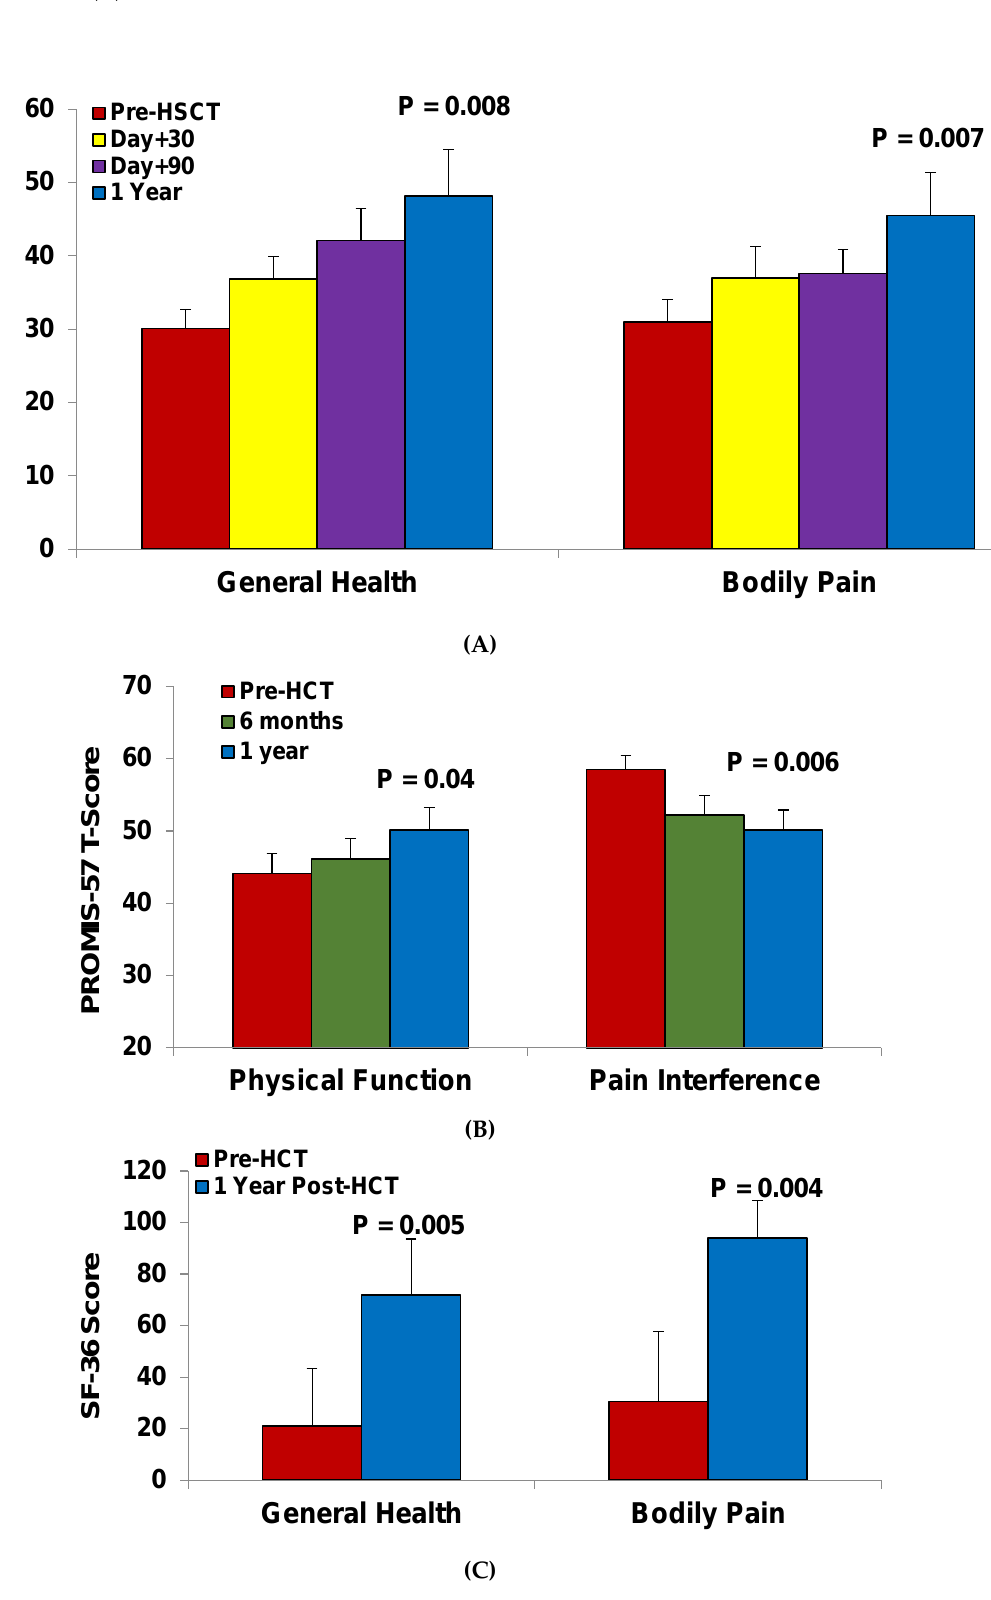
Figure 2. Increased health-related quality of life after hematopoietic stem cell transplantation in adults with sickle cell disease from ( A ) the University of Illinois ( n = 9), ( B ) University of Baskent ( n = 20), and ( C ) the multi-center STRIDE study ( n = 17).